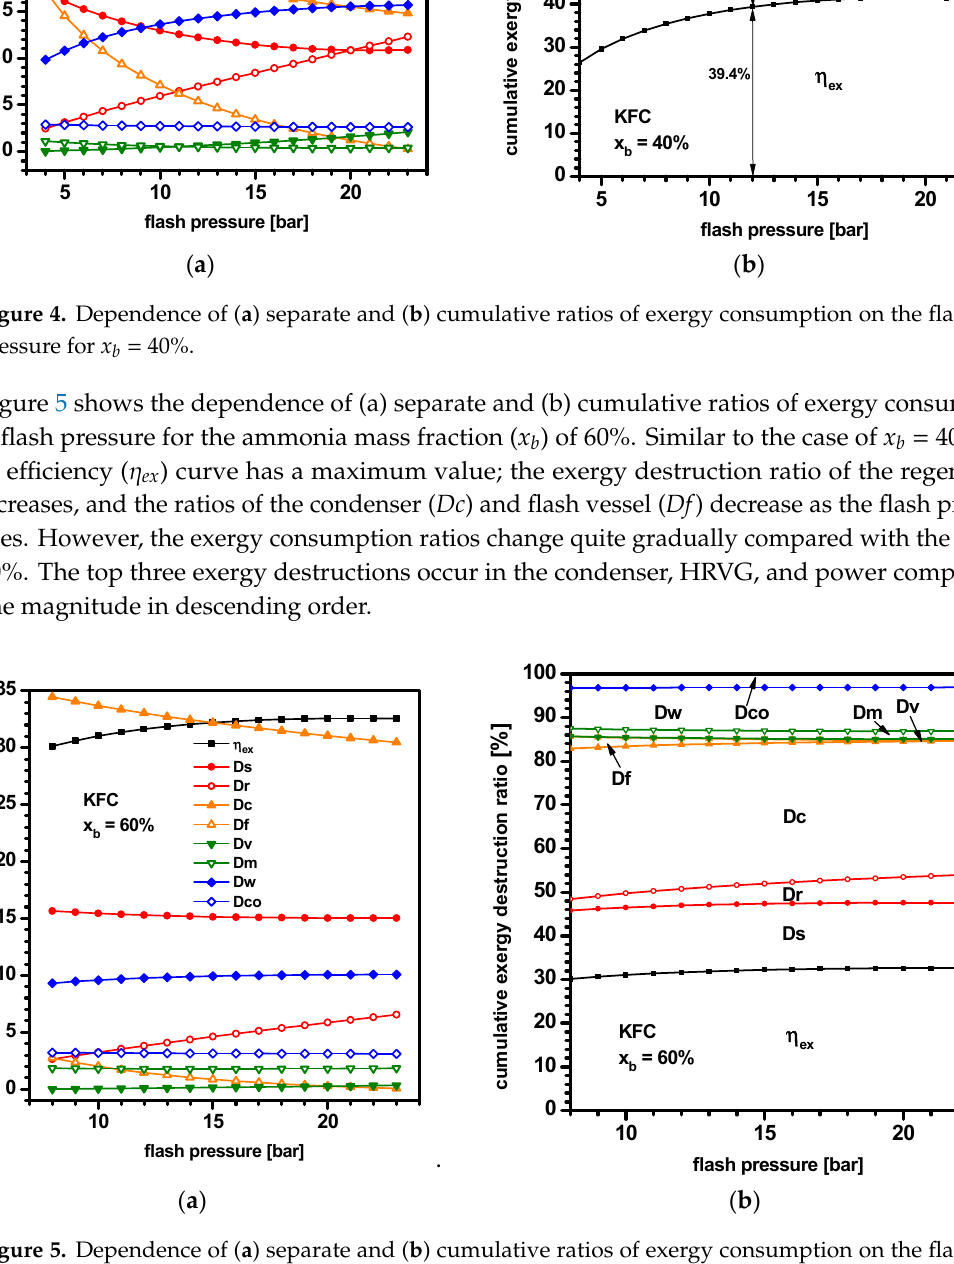
Figure 4. Dependence of ( a ) separate and ( b ) cumulative ratios of exergy consumption on the flash pressure for x b = 40%. Table 3. Example data of separate and cumulative ratios of exergy consumption for x b = 40% and P f = 12bar.